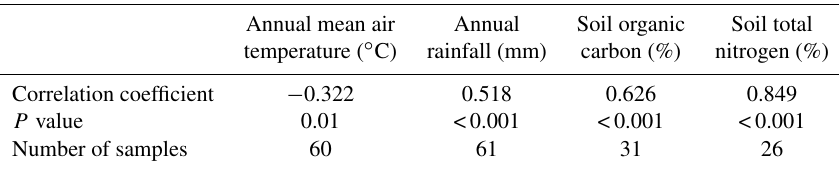
Table 2. Correlation between annual soil CO 2 emissions (MgCO 2 ha − 1 yr − 1 ) and environmental factors in African natural terrestrial sys-